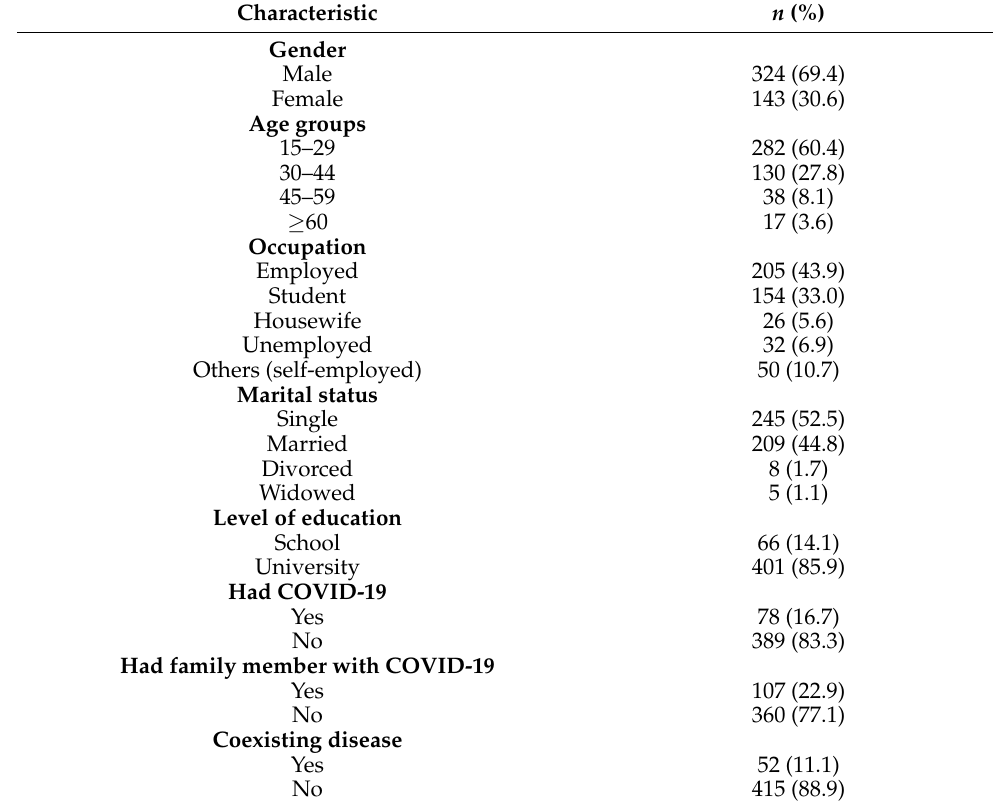
Table 1. Demographic Characteristics ( n = 467).